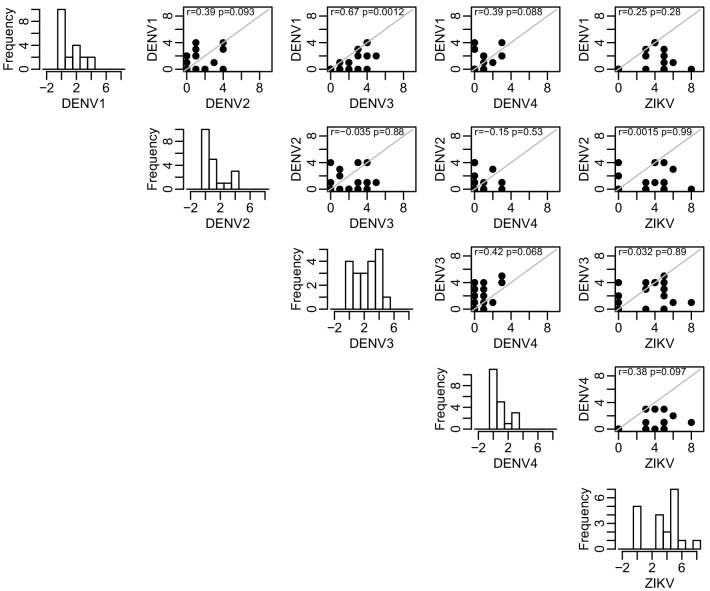
Correlation between rise in DENV and ZIKV neutralization log titres between 2013–2015 for participants who were initially seronegative (i.e. log titre <2) to all five viruses in 2013 (n = 20).There is significant correlation between DENV-1 and DENV-3 viruses (top row, p=0.0012), suggesting likely cross-reactive responses. However, changes in ZIKV titres were not associated with responses to any of DENV viruses (far right column), which strongly indicates that the ZIKV results were genuine infections..